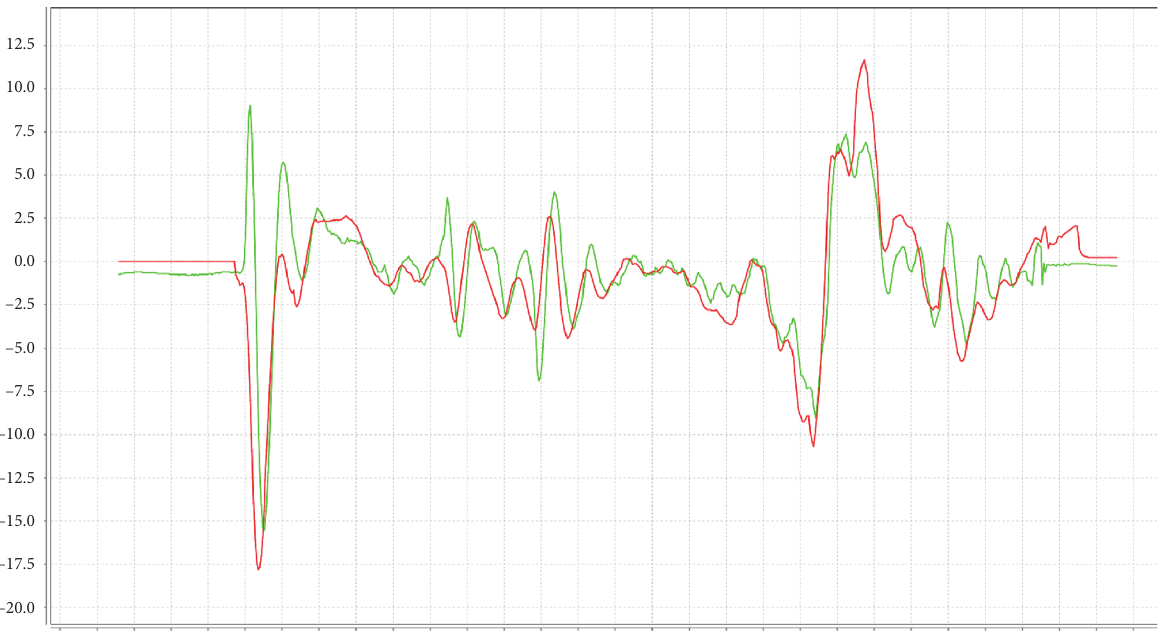
Figure 19: Actual flight roll angle graph.